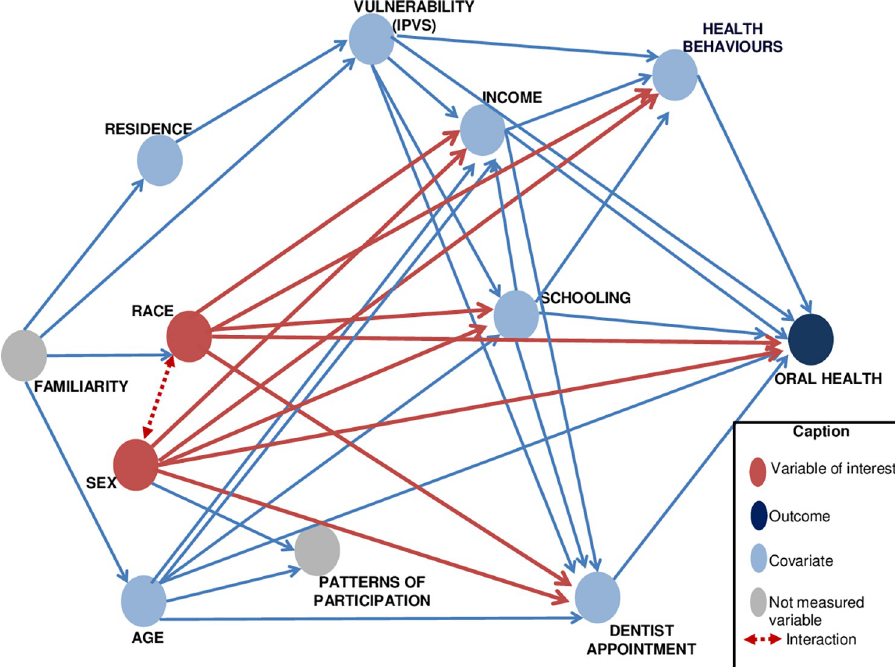
Fig 1. Directed acyclic graphs, with the variables and implications tested, for tooth loss according to race/skin color and sex.